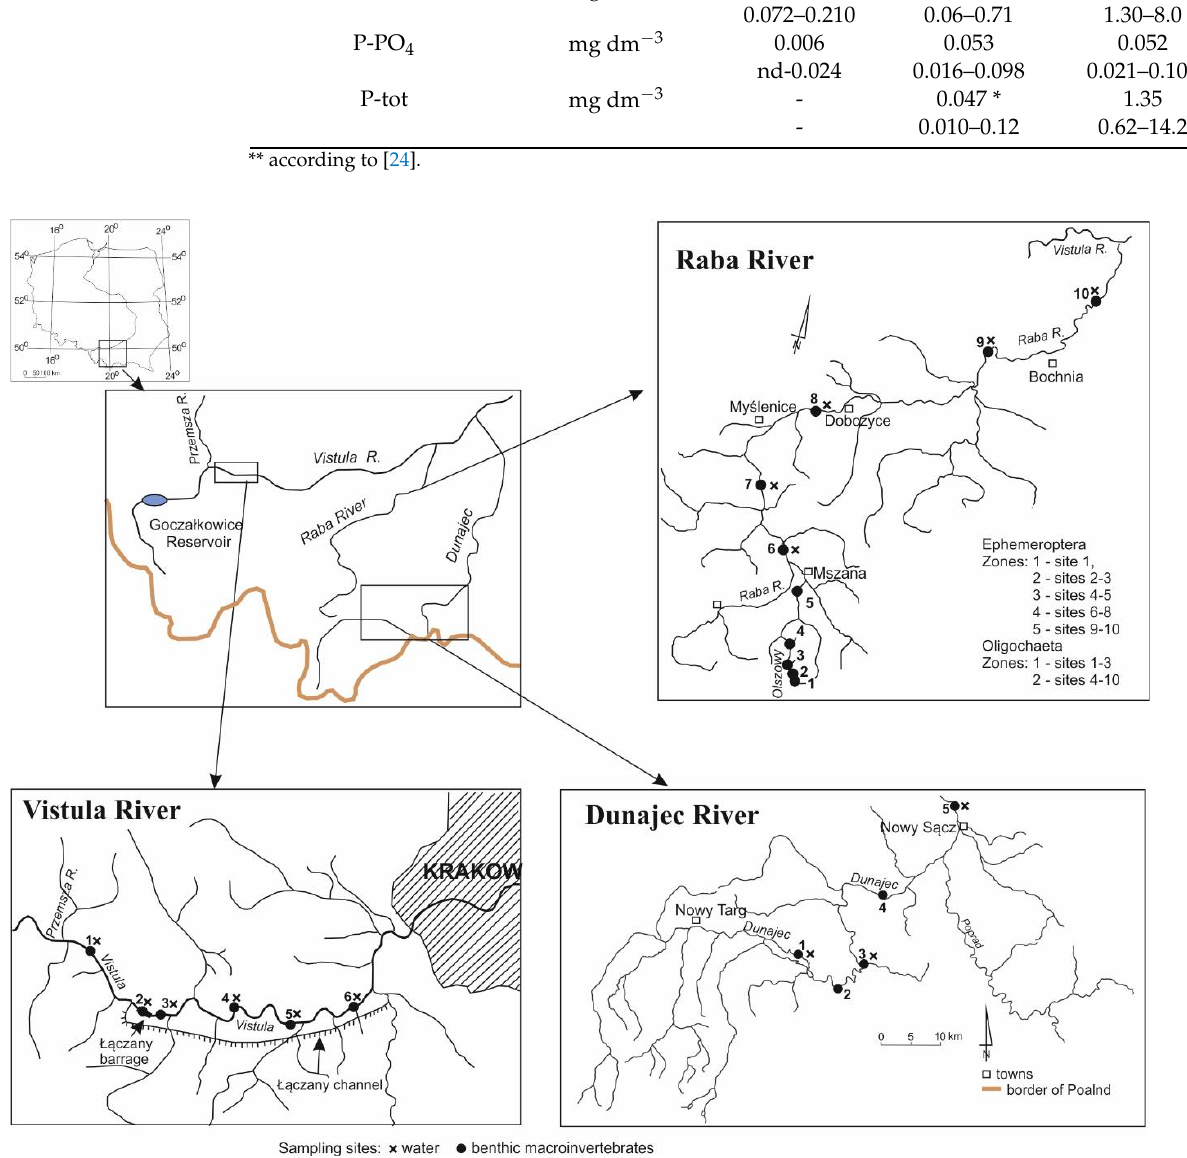
Figure 1. Sampling sites in the Raba, Dunajec, and Vistula rivers.